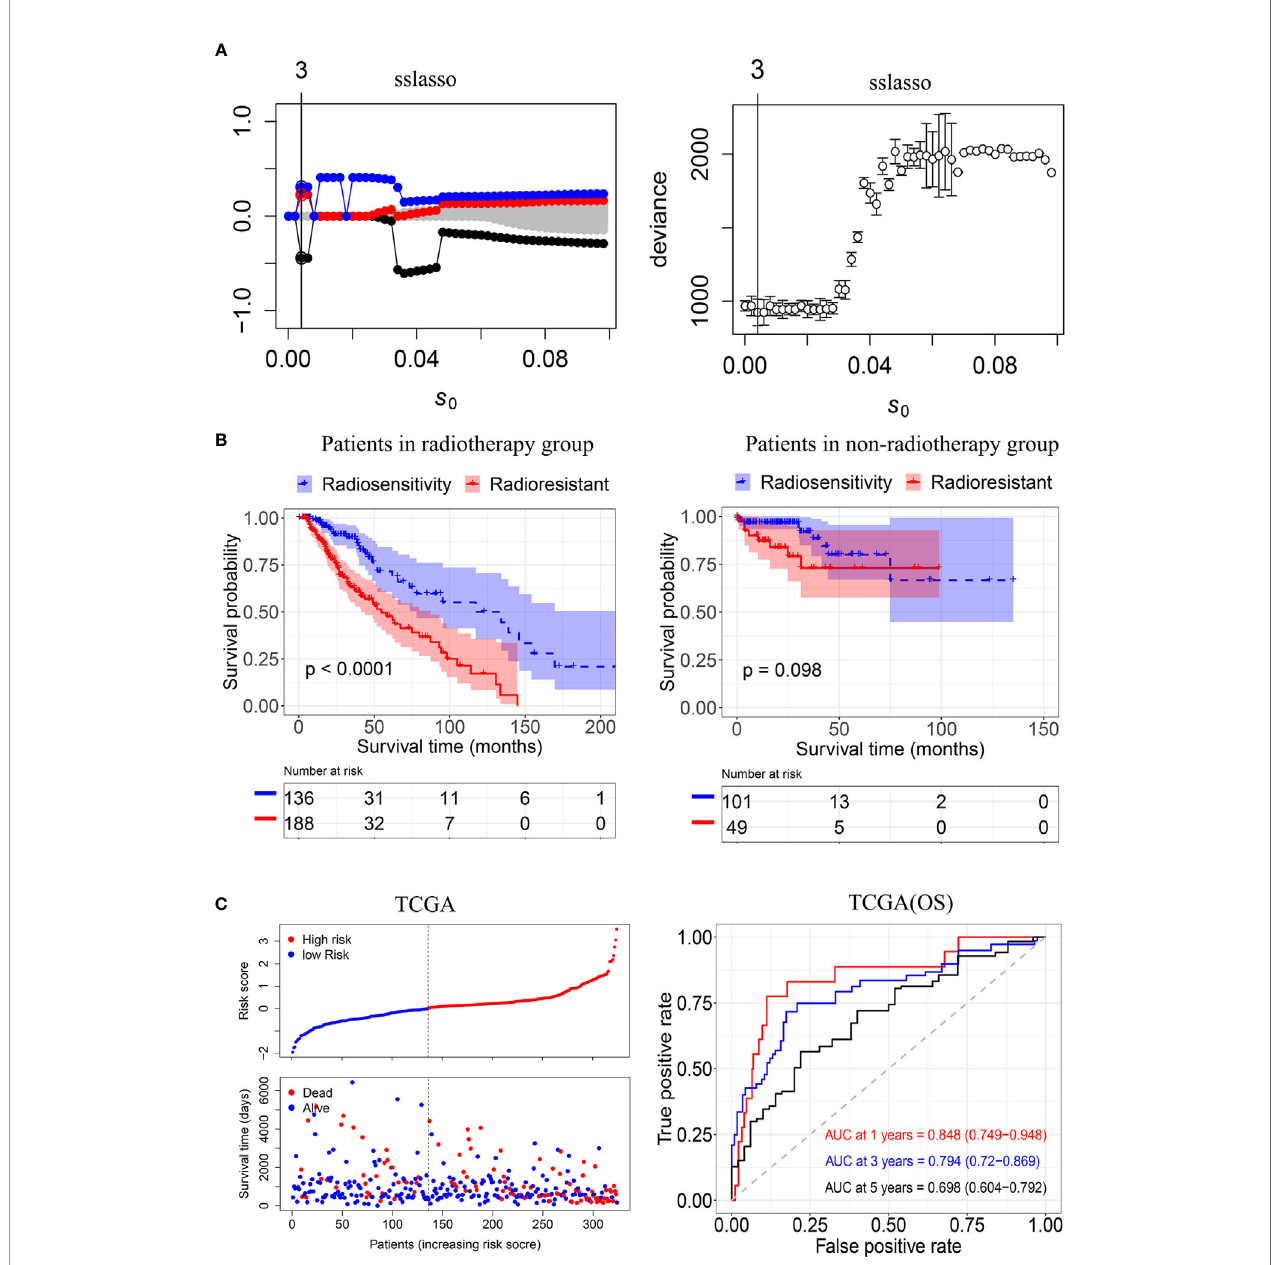
FIGURE 3 | Construction of the radiosensitivity-related risk score model. (A) The solution paths and partial log-likelihood pro fi les of the spike-and-slab model. (B) Kaplan – Meier curves for the RS group and RR group in patients with radiotherapy and patients did not receive radiotherapy. RR: radioresistant group. RS: radiosensitive group. (C) Risk scores distribution of each patient in the TCGA(OS) and time-dependent ROC curve analysis of the radiosensitivity-related risk score in the TCGA(OS). OS: Overall